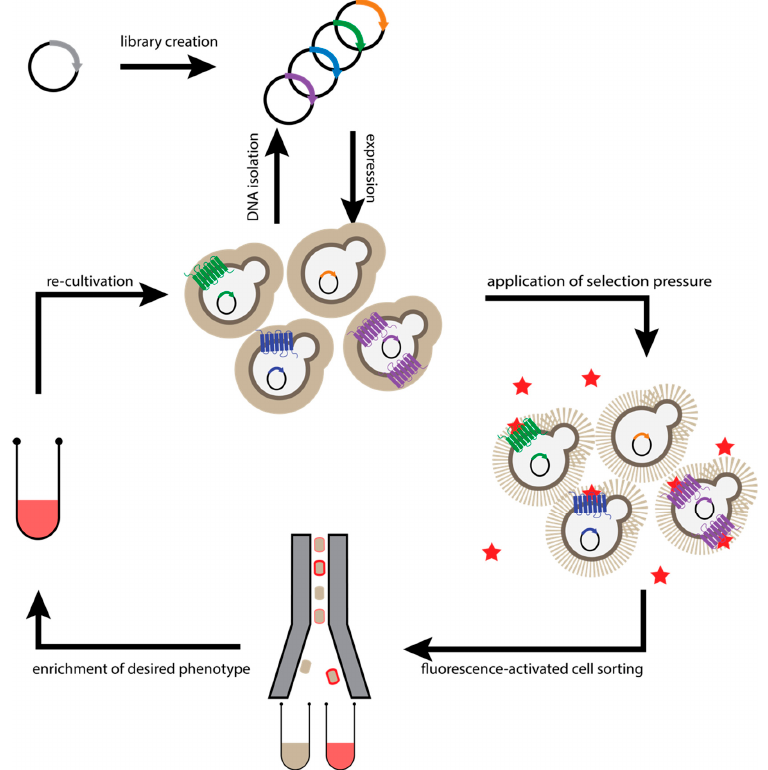
Figure 4. Workflow of Saccharomyces cerevisiae -Based Receptor Evolution (SaBRE). Evolution of GPCRs is initiated by di- versification of the receptor gene. The resulting DNA library is used for transformation of S. cerevisiae cells, so that each cell takes up at most one plasmid molecule. Subsequently, one receptor variant is expressed in the plasma membrane of a single cell. To probe surface expression levels with a fluorescently labelled ligand (red star), the yeast cell wall was per- meabilized (dashed oval). After incubation with fluorescently labelled ligand to bind to saturation, cell surface expression levels determine the number of bound ligands, and the cells exhibiting the highest fluorescence (i.e., cells with the highest GPCR expression) are enriched by FACS. Sorted cells were propagated in growth medium. Re-grown cell pools can either be subjected to additional rounds of selection or plasmids can be isolated for analysis of individual clones.